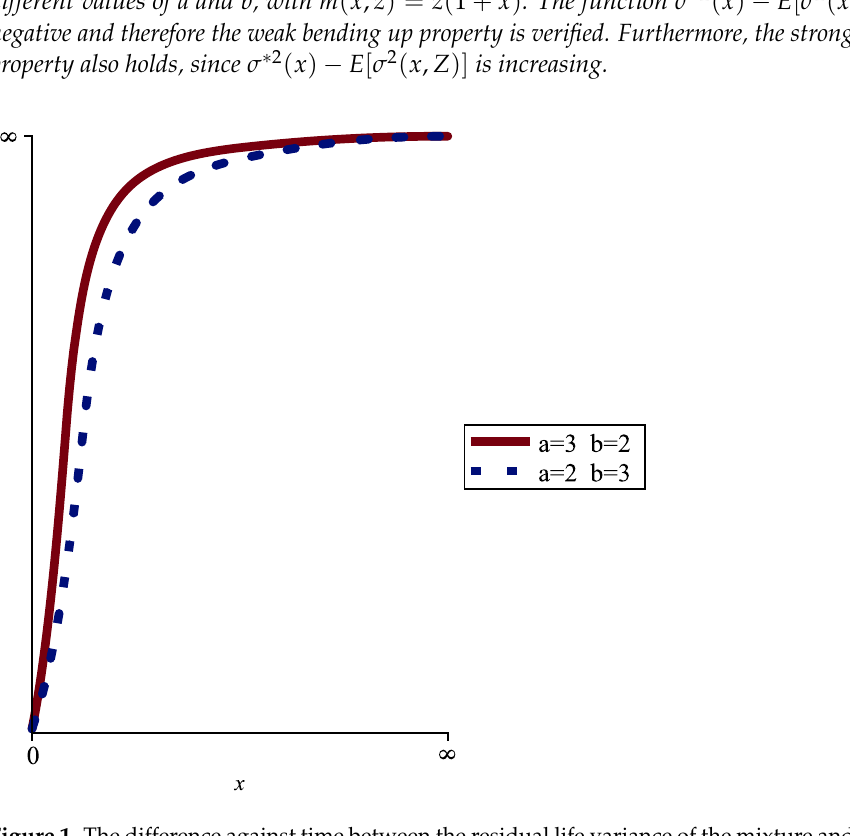
Figure 1. The difference against time between the residual life variance of the mixture and the average variance of the residual lives of the subpopulations, σ ∗ ( x ) − E [ σ 2 ( x , Z )] . The mixture follows the mean proportional residual life model with the baseline m X ( x ) = 1 + x , and Z is a beta random variable with parameters a and b